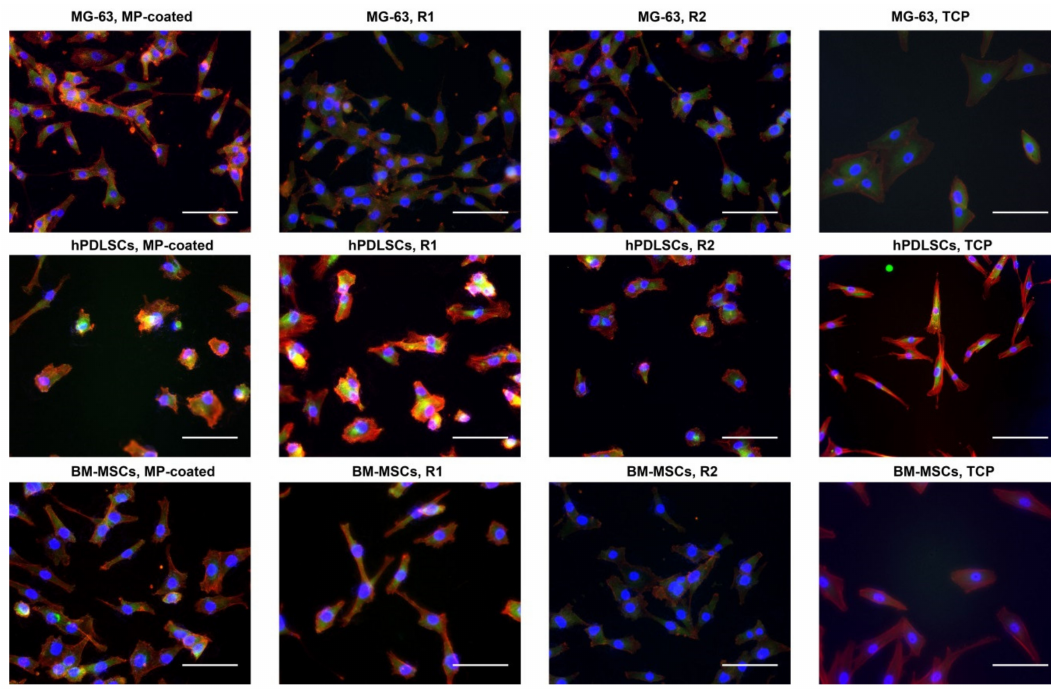
Figure 1. Fluorescence microscopy images of MG-63 cells, hPDLSCs, and BM-MSCs cultured on titanium surfaces and tissue culture plastic (TCP). Cell culture was performed on multi-phosphonate (MP)-coated as well as sand-blasted and acid-etched reference surfaces (R1, R2) and tissue culture plastic (TCP) as control for 48 h; F-actin was stained with TRITC-conjugated Phalloidin ( red ), focal adhesions with anti-Vinculin visualized by fluoresceinisothiocyanat (FITC) ( green ) and the nucleus with 4 (cid:48) ,6-Diamidin-2-phenylindol (DAPI) ( blue ). Scale bars correspond to 100 µ